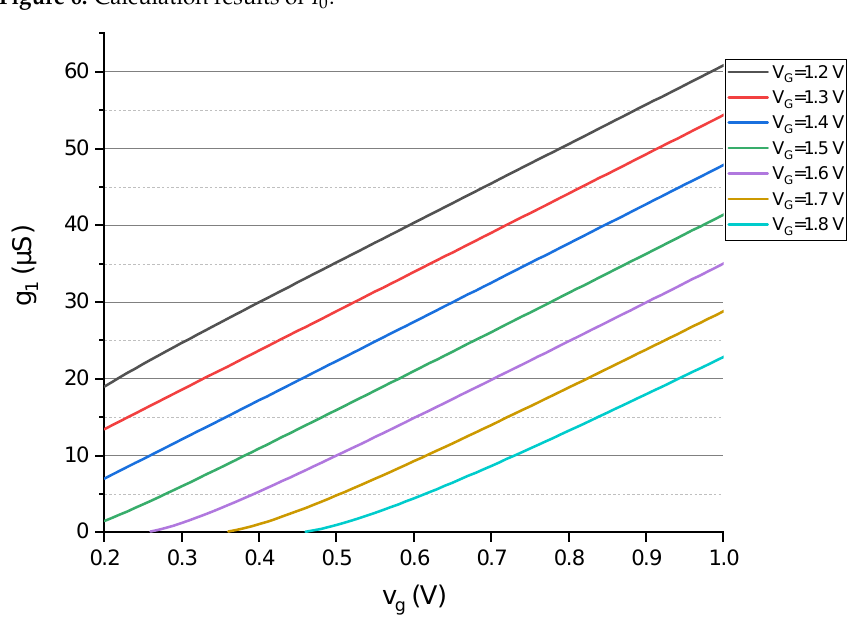
Figure 7. Calculation results of g 1